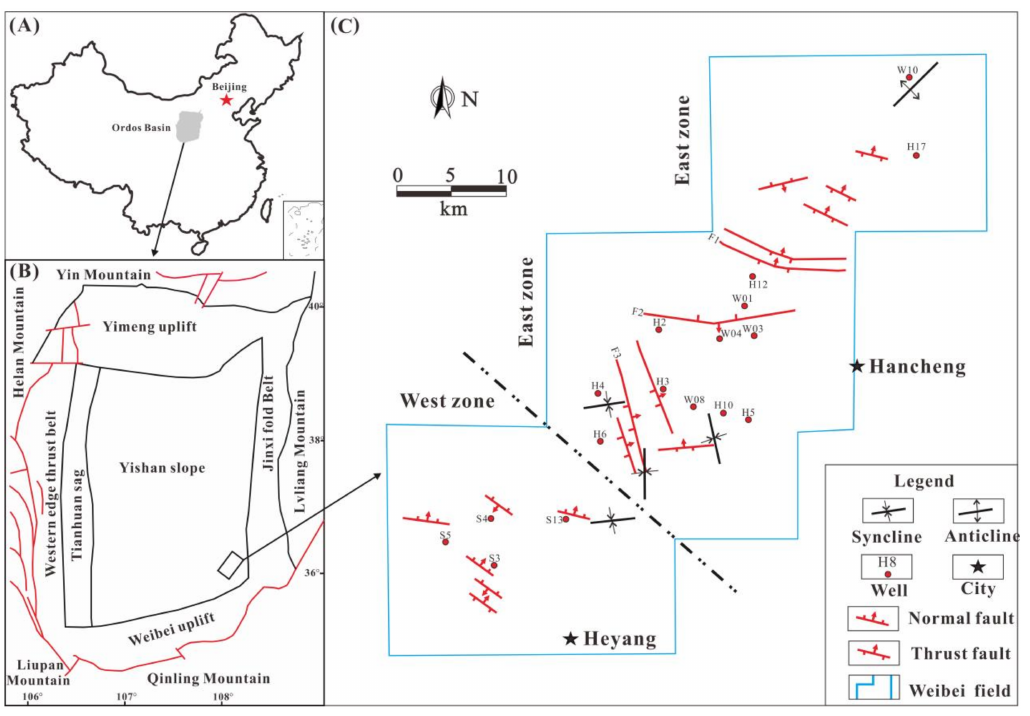
Figure 1. Location of the Ordos Basin in North China ( A ); Location of the Weibei Field ( B ); Geological structures and locations of the exploration wells in the Weibei Field ( C ).